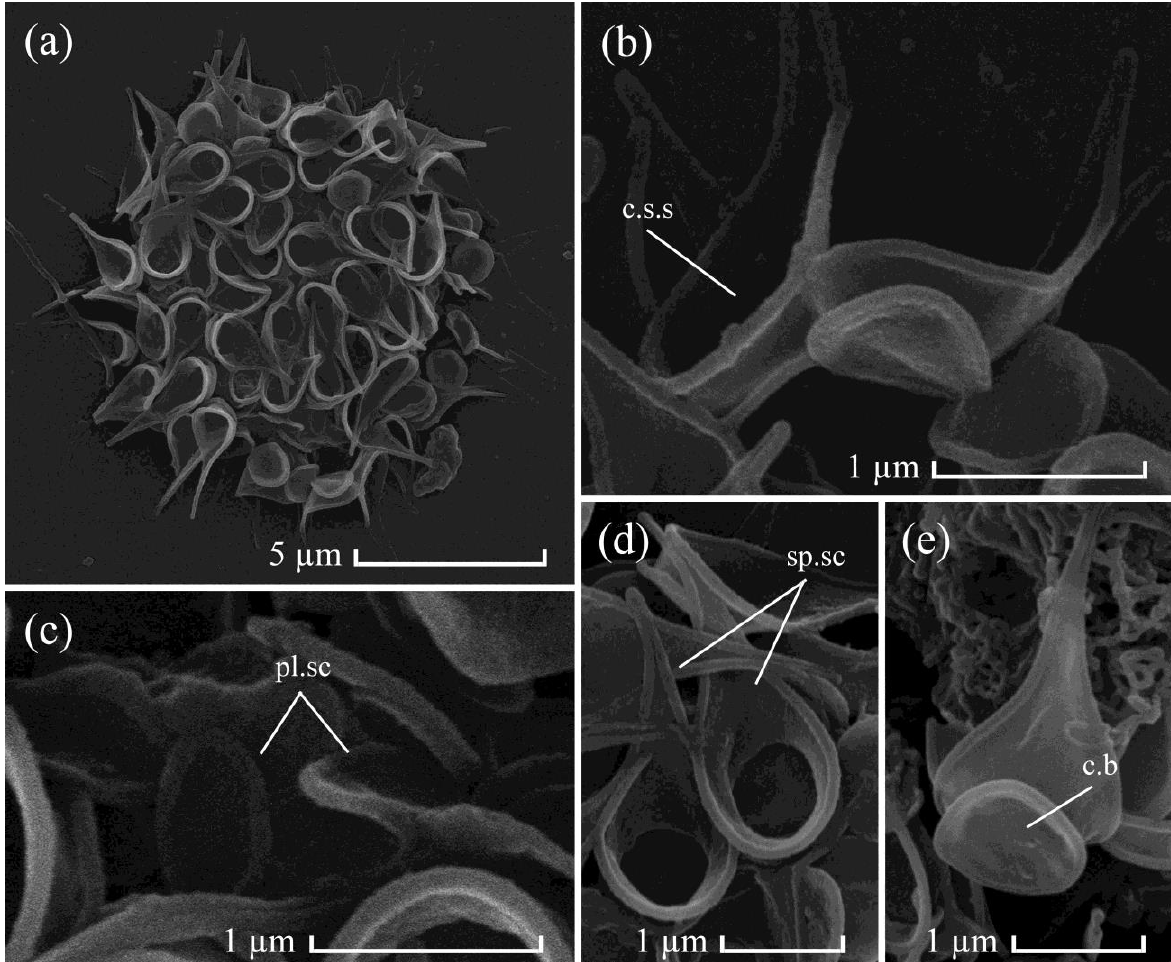
Figure 6. Morphology of observed scales of new centrohelid species Pterocystis anglocollegarum sp. n., SEM: (a) scales of a single cell; (b) spine scales, side view; (c) plate scales; (d) spine scales, view from above; (e) spine scale, bottom view. Abbreviations: c.b = circular base of spine scale; c.s.s = cup-shaped structure. Other abbreviations as in Figures 1 and